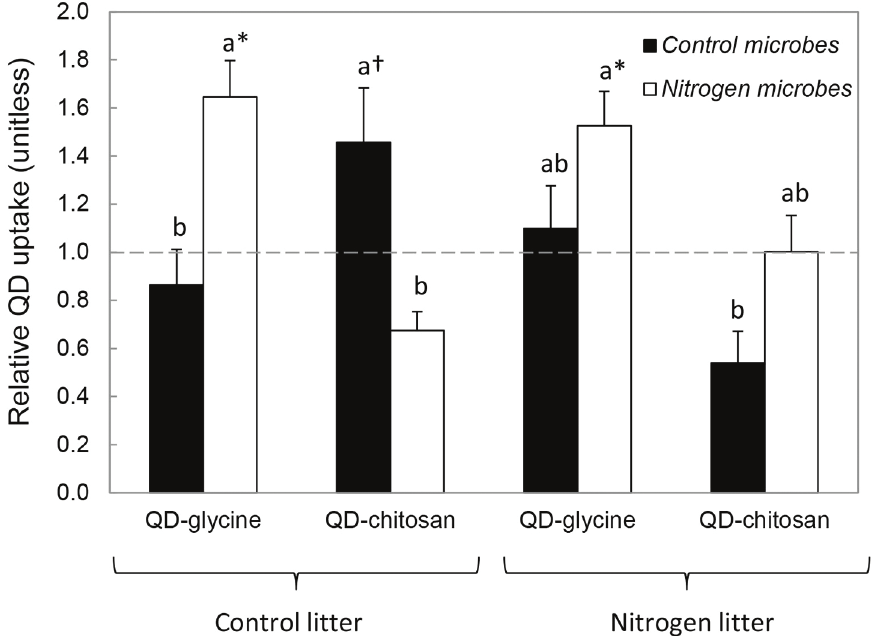
Fig 2. Relative uptake capacity of QD-glycine and QD-chitosan. Relative uptake capacity is QD uptake capacity of QD-compounds (as QDs μ m 3 d -1 ) divided by QD uptake capacity of QD-references. Microbes from control versus N-fertilized plots were added to control versus N-fertilized litter in microbial cages, in a reciprocal transplant design. All microbial cages were decomposed in control plots. Microbe origin, litter origin, and compound type interacted significantly to influence relative QD uptake (P = 0.003). Uptake values are relative to uptake rates of QD-references. Relative QD uptake > 1 (dashed line) indicates that fungi were targeting the organic N compound, rather than the QD or the carboxyl groups embedded in the QD surface. Symbols indicate significant ( * ) or marginally significant ( † ) uptake of QD-glycine or QD-chitosan relative to QD-references. Treatments with different letters are significantly different from one another (P < 0.05). Bars are means ± 1SE of 5